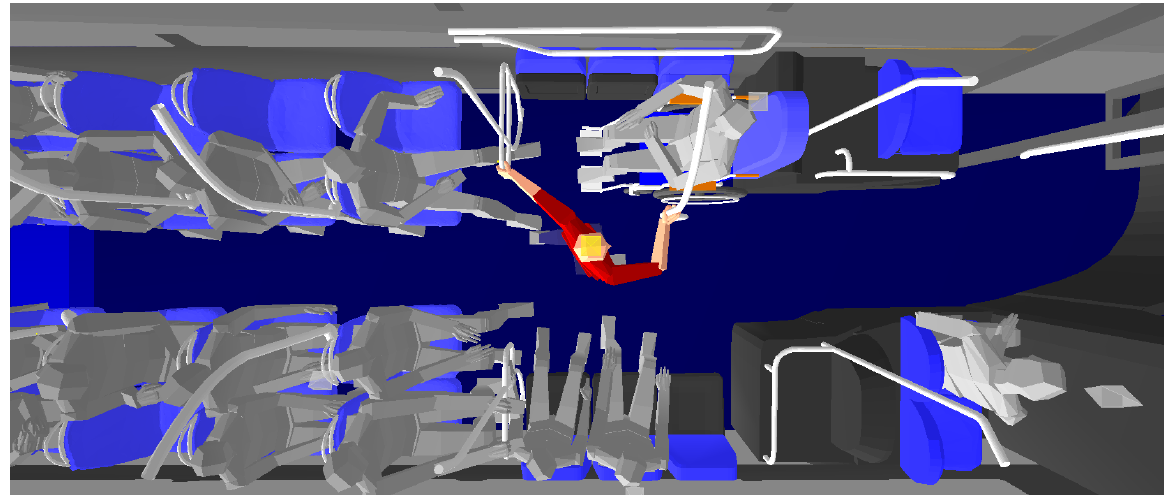
Figure 12. Plan view of the P13 showing the grip of the two left hand handles.